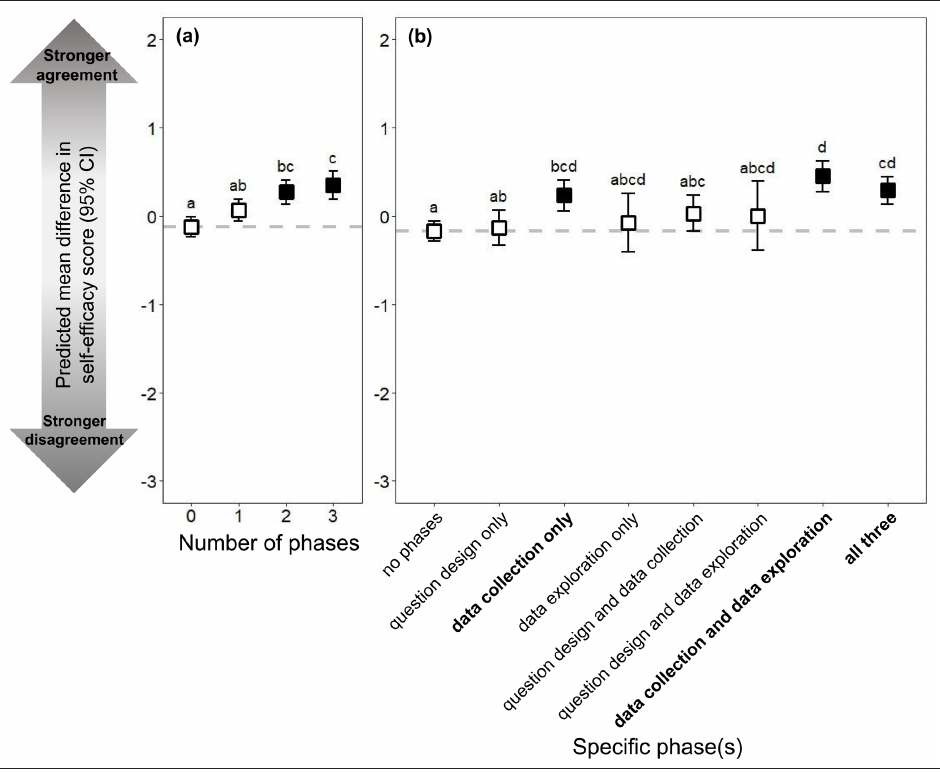
Figure 3 The predicted mean post-pre difference in self-efficacy scores (a) increased with the more phases in which a respondent participated, (b) with the greatest increases associated with data collection. Each point is the Estimated Marginal Mean (EMM) post-pre difference in self-efficacy scores with 95% confidence intervals (CI). Means not sharing any letter are statistically significantly different from the other means by the t-test adjusted using the Tukey method. The horizontal dashed line represents the score for those who did not participate at all, and black squares indicate which values are statistically significantly different to the baseline (“no phases”). The range on the y-axis reflects the range of values in the matched pre- and post-survey